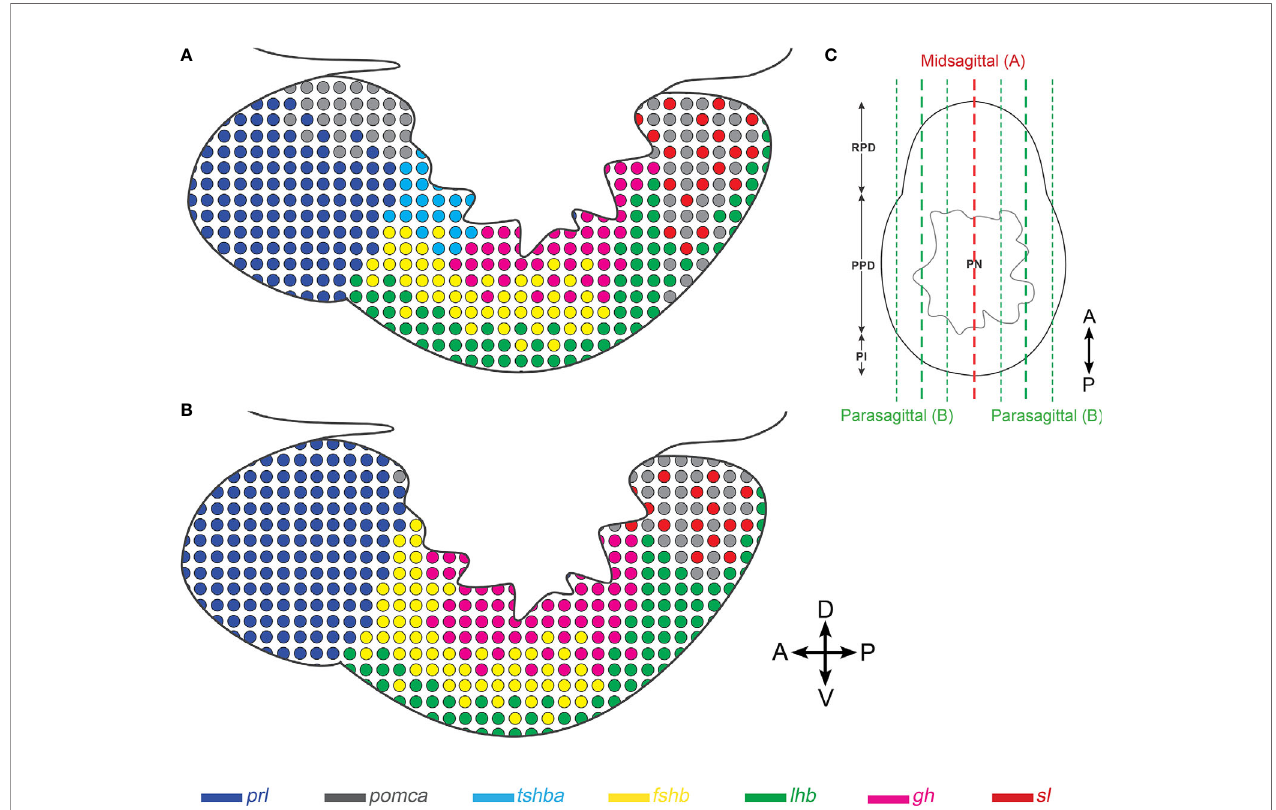
FIGURE 7 | Schematic illustration showing differences in the distribution of endocrine cell populations between mid-sagittal and para-sagittal sections of the medaka pituitary. The schemas are drawn based on mid- (A) and para-sagittal (B) points of view. (C) Transverse view of medaka pituitary showing approximate location of mid-sagittal (red) and para-sagittal sections (green). Four direction arrows display the direction of the pituitary (A, anterior; P, posterior; D, dorsal; V,